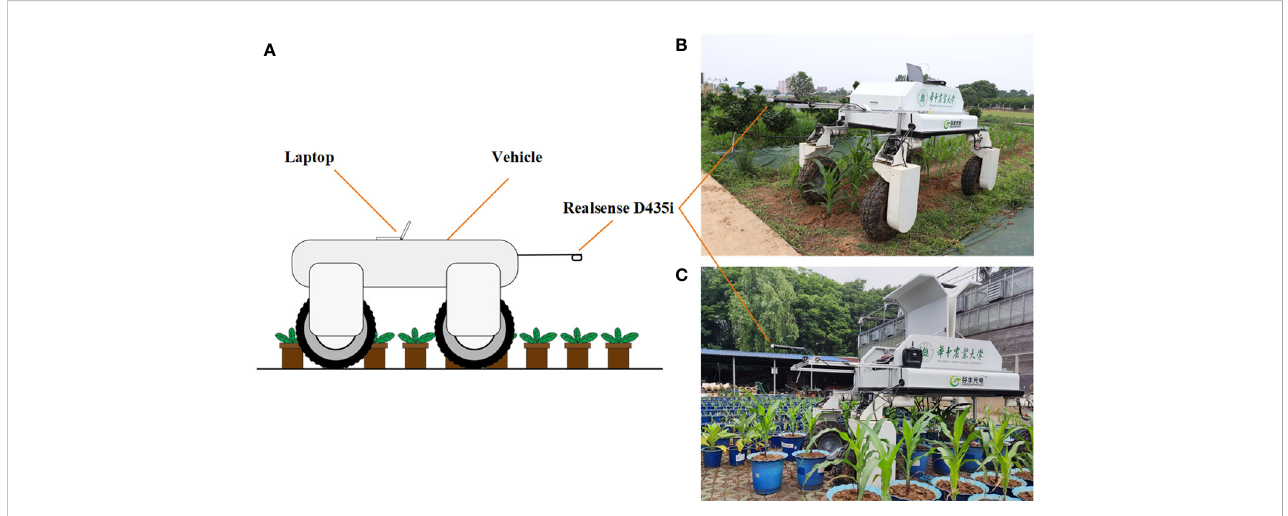
FIGURE 2 Data acquisition based on the movable platform; (A) Schematic diagram of data acquisition (B) Data acquisition in the fi eld; (C) Data acquisition in pot fi